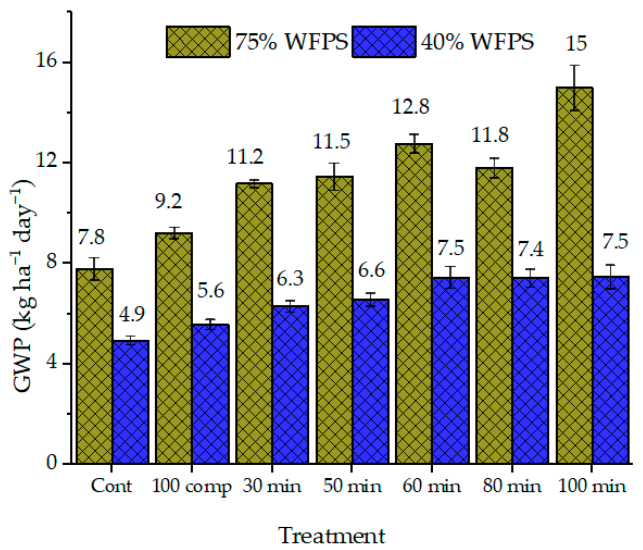
Figure 1. Global warming potential (GWP) in different fertilizer types and water filled pore-space (WFPS) (40% and 75%).